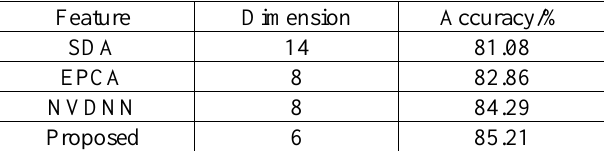
Table 2. Recognition rate under different feature extraction